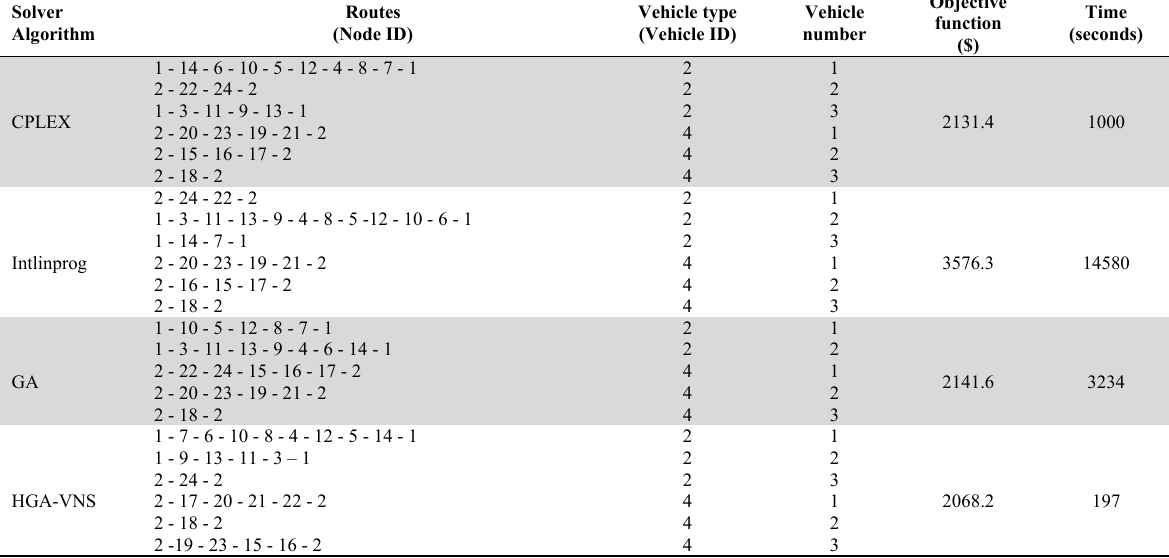
Normal demand fulfillment performance of the solvers and algorithms.